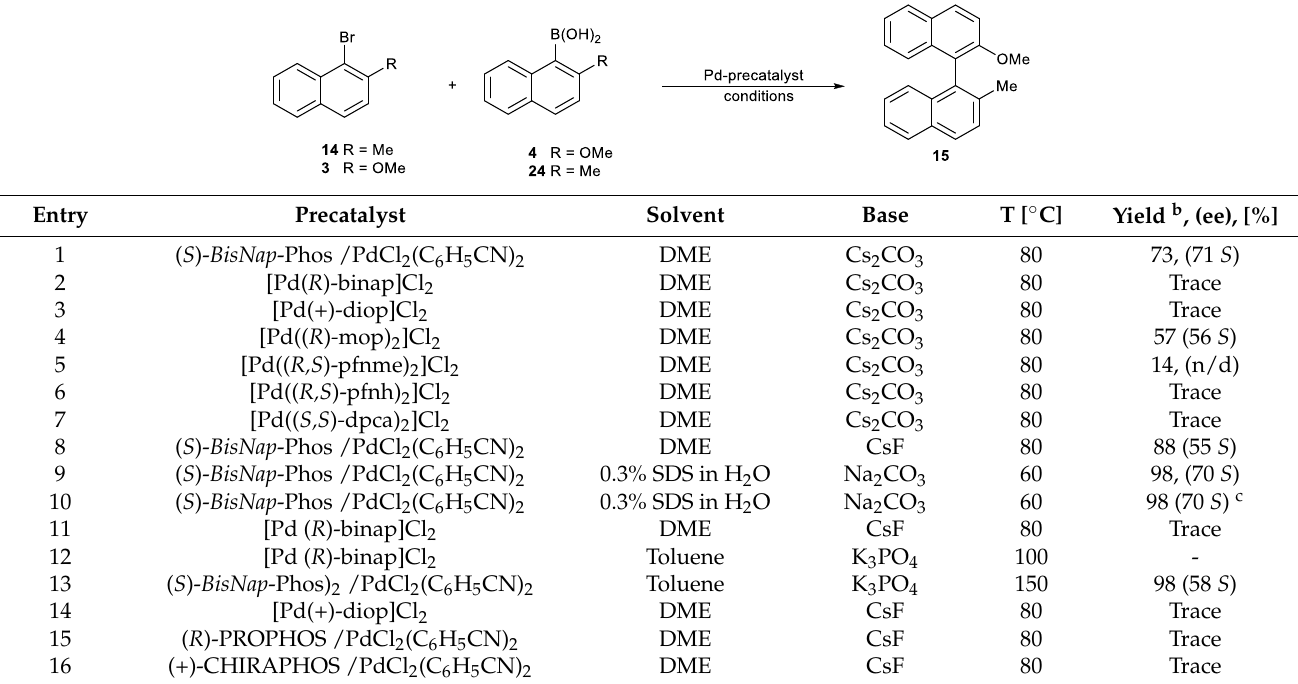
Table 8. Ligand activity in asymmetric synthesis of 15 a .